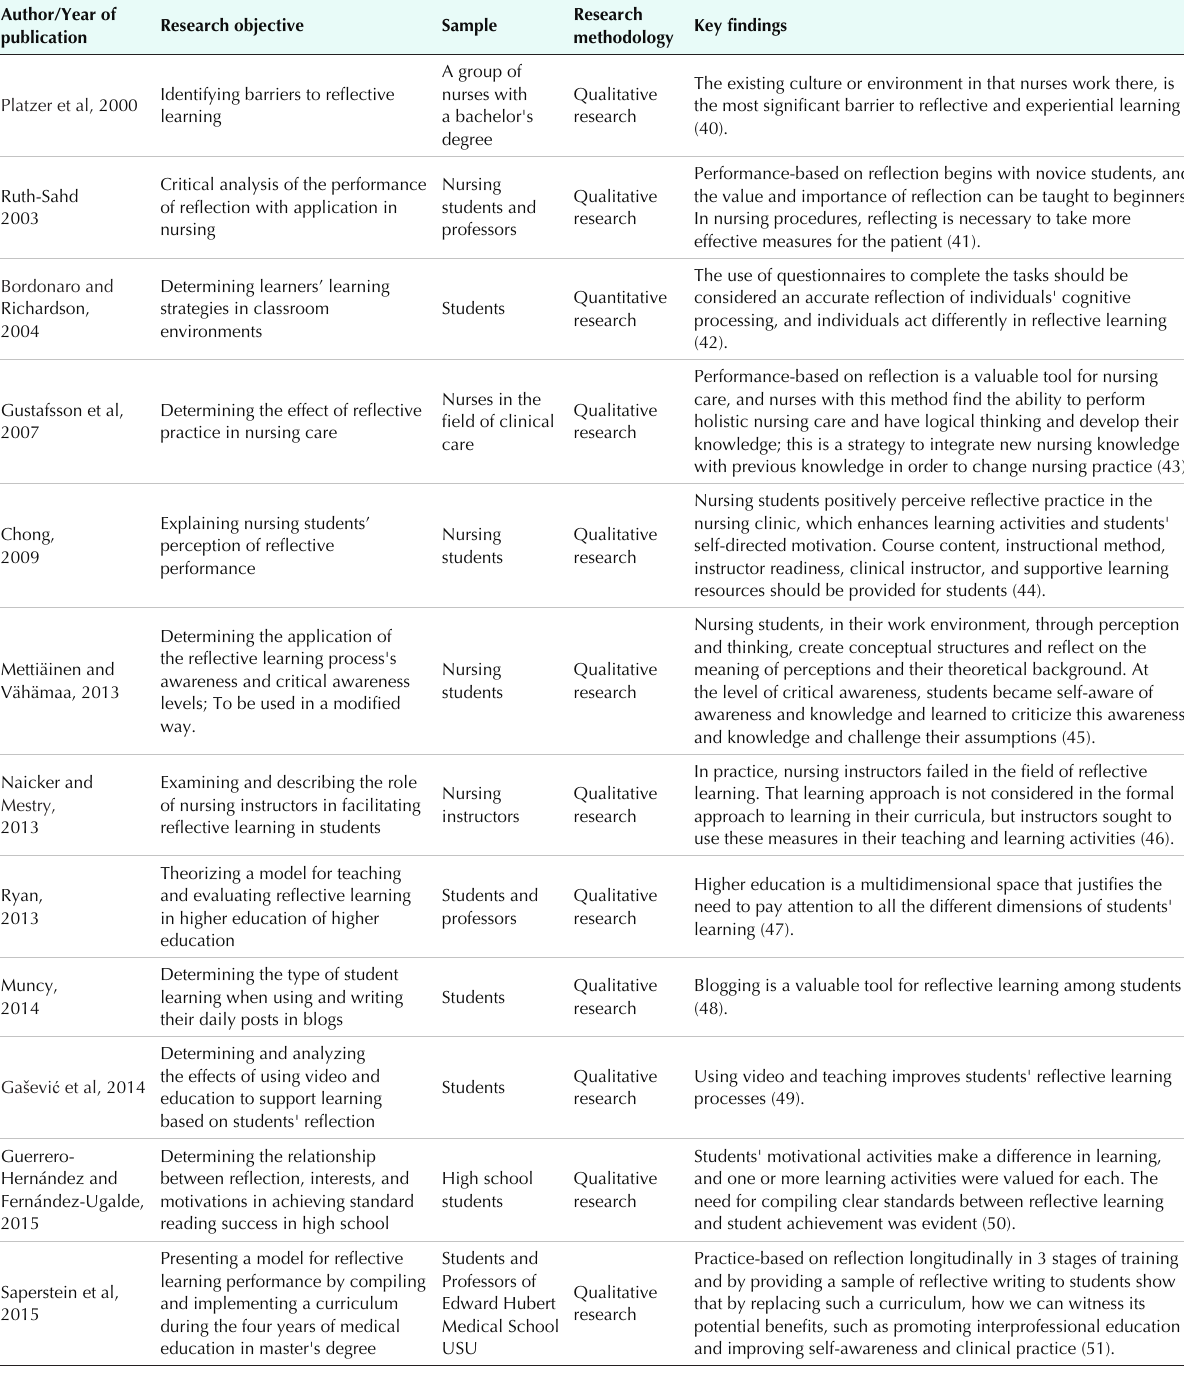
Table 2. The research on reflective learning in clinical nursing